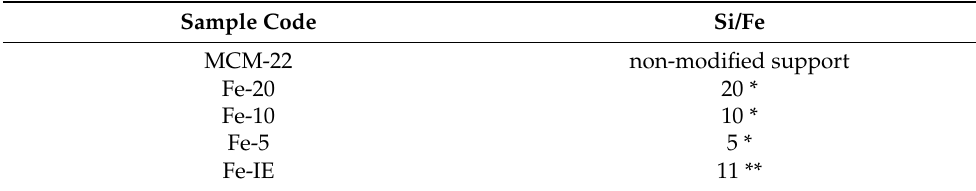
Table 7. List of the prepared samples with their codes and corresponding calculated * Si/Fe molar ratios. Sample Code Si/Fe MCM-22 non-modified support Fe-20 20 * Fe-10 10 * Fe-5 5 * Fe-IE 11